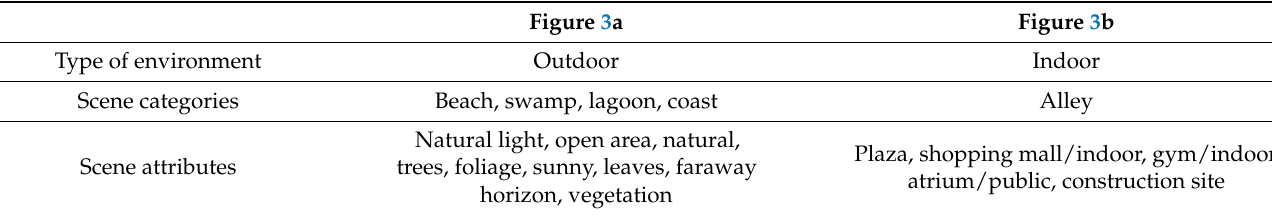
Table 2. Scene category and attribute outputs from Places365-CNN.